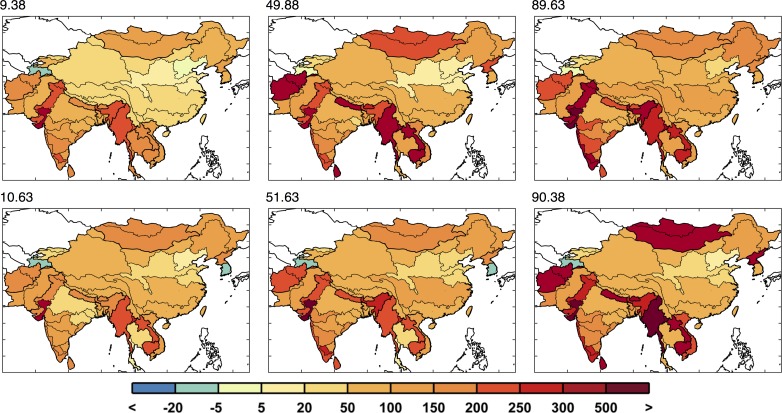
Domestic water requirement change by region (in %) around the 10th percentile, median, and 90th percentile, two each, similar to the metric used in Fig 18.Top label shows the percentile.